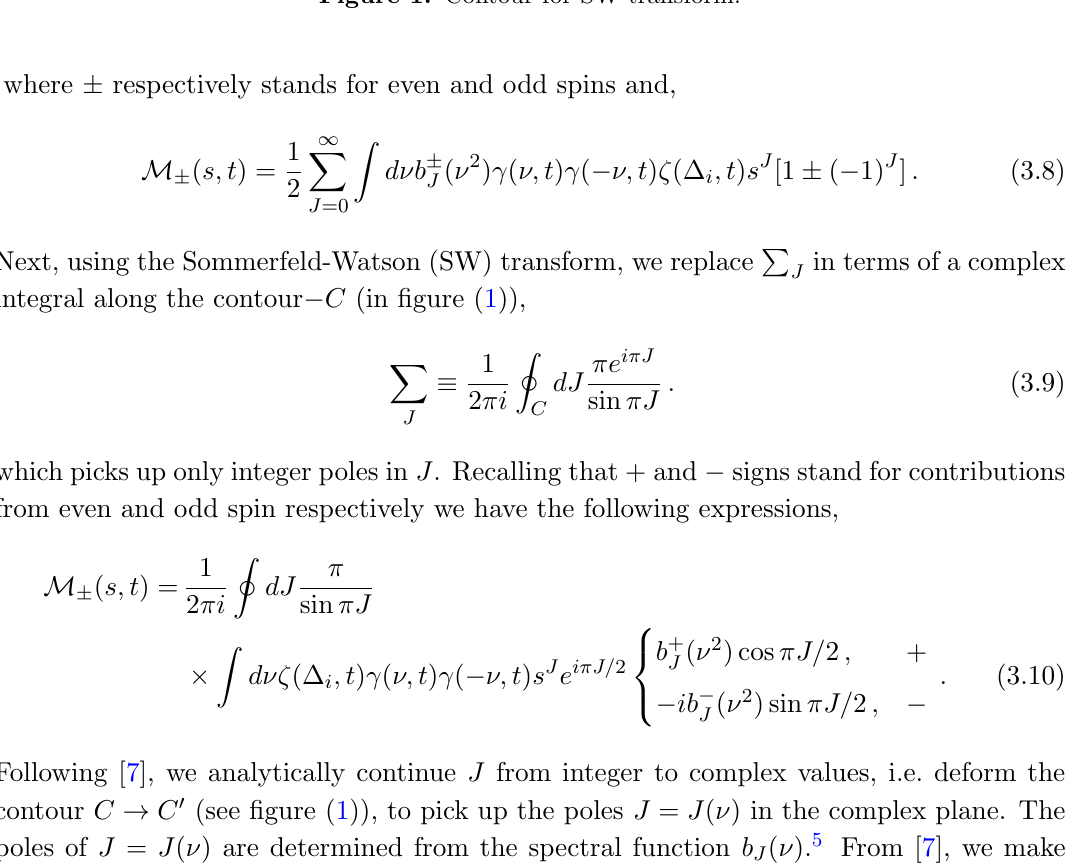
Figure 1. Contour for SW